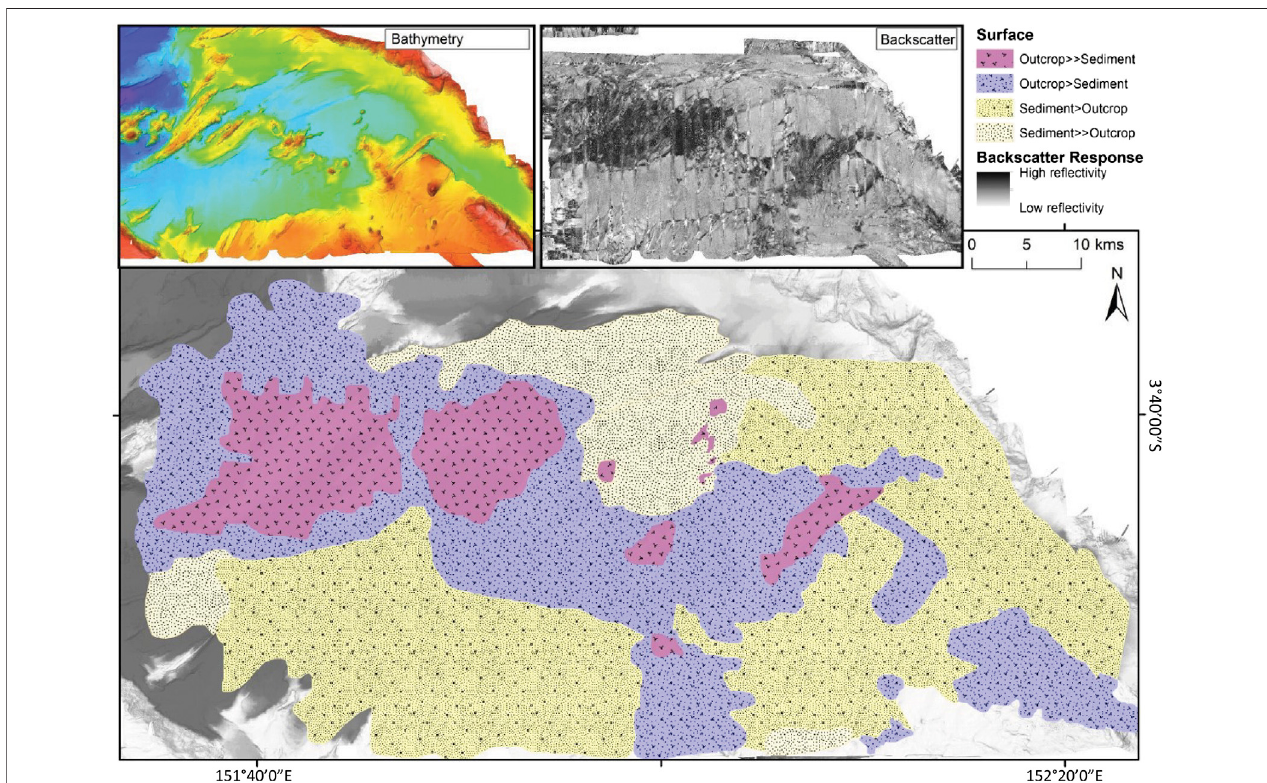
FIGURE 4 | Sediment-outcrop map of the EMB. Map polygons re fl ect the interpretation of surface re fl ectivity data. Variable sediment cover dominates. Volcanic features identi fi ed in Figure 2 correspond to high-intensity, high-re fl ectivity backscatter response zones (outcrop >> sediment).